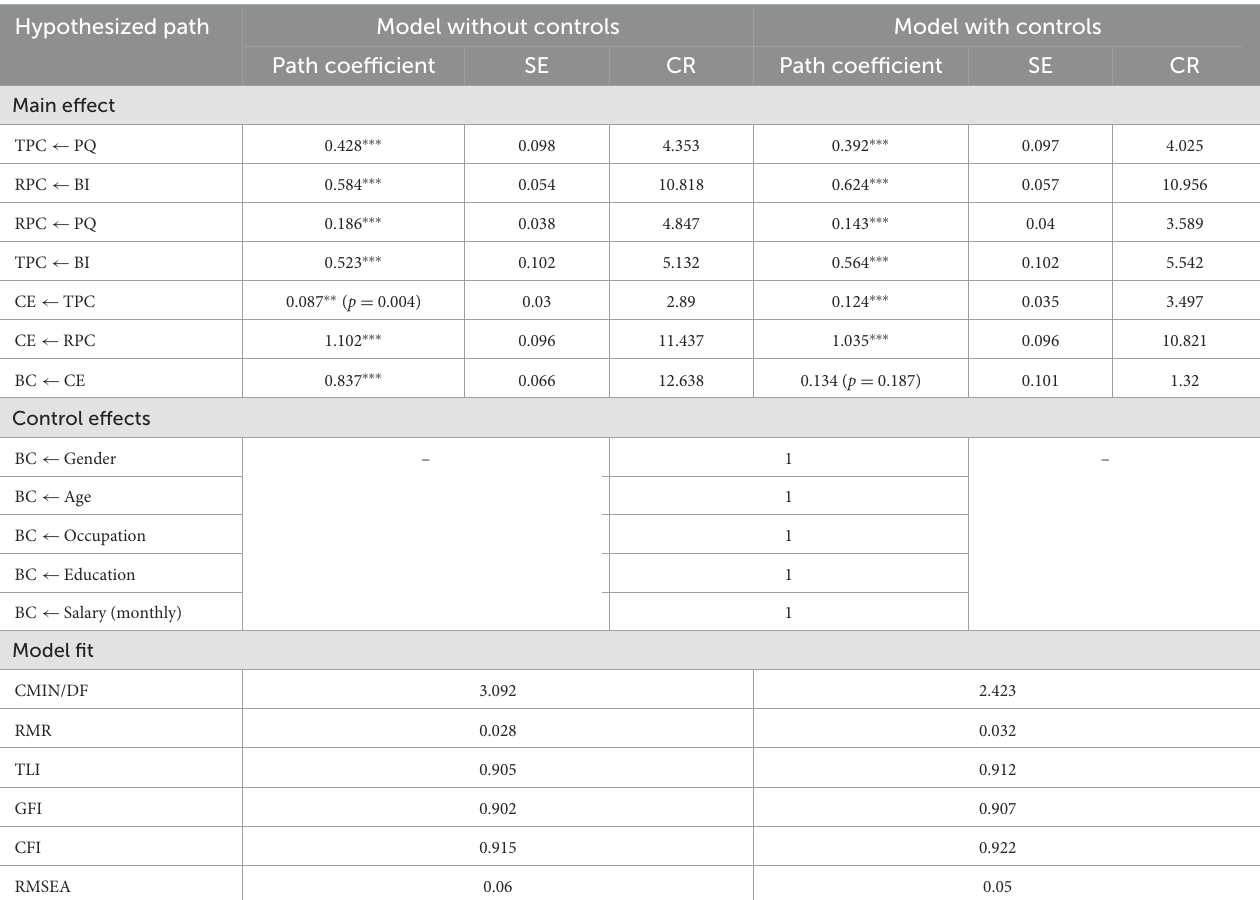
TABLE 5 Results of SEM. Hypothesized